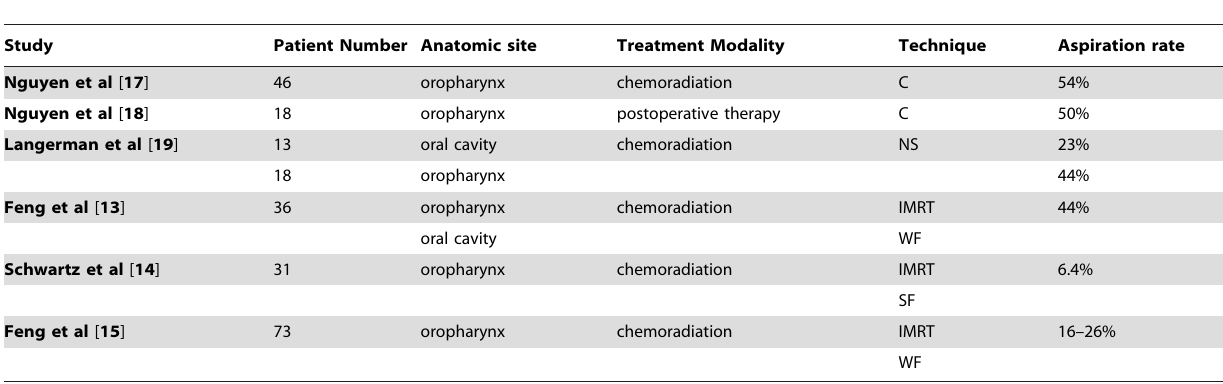
Table 3. Aspiration rate reported in the literature following radiotherapy for non-laryngeal and non-hypopharyngeal head and neck cancer.